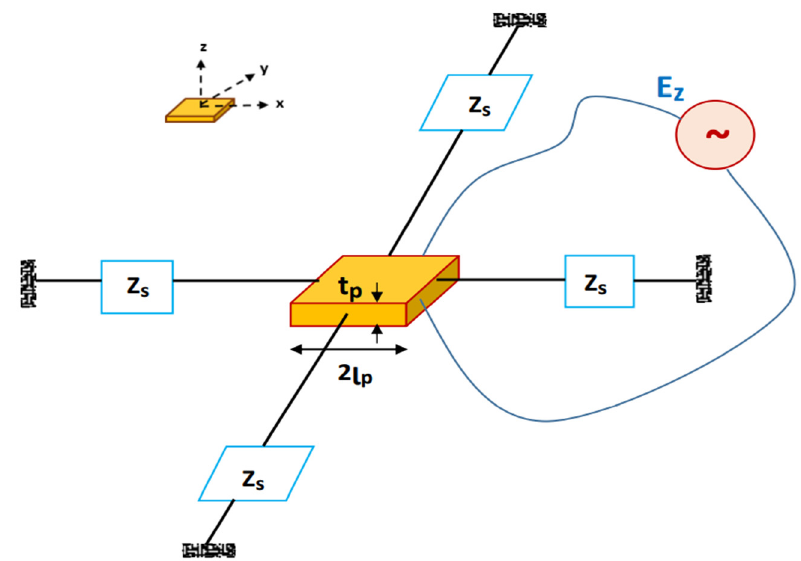
Figure 2. Interactive model of PZT patch and concrete structure.